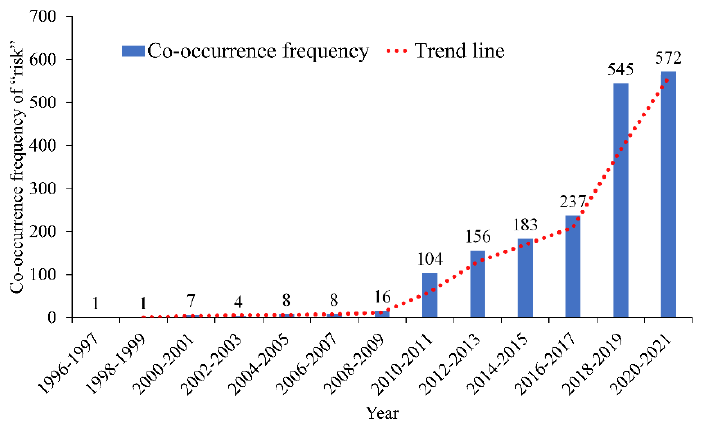
Figure 3. Co-occurrence frequency and time distribution of “risk”.